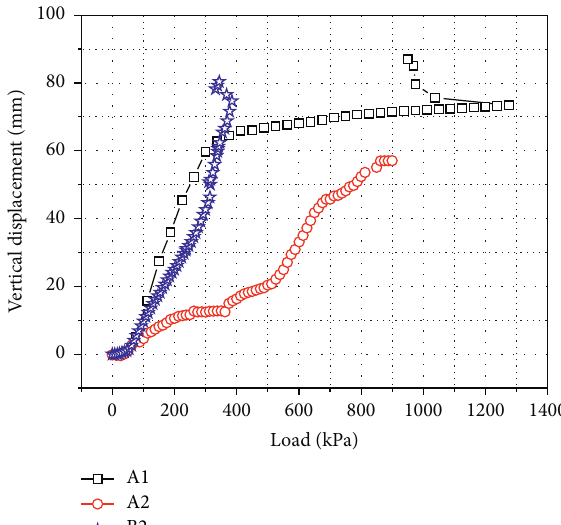
Figure 7: Load-displacement curve.